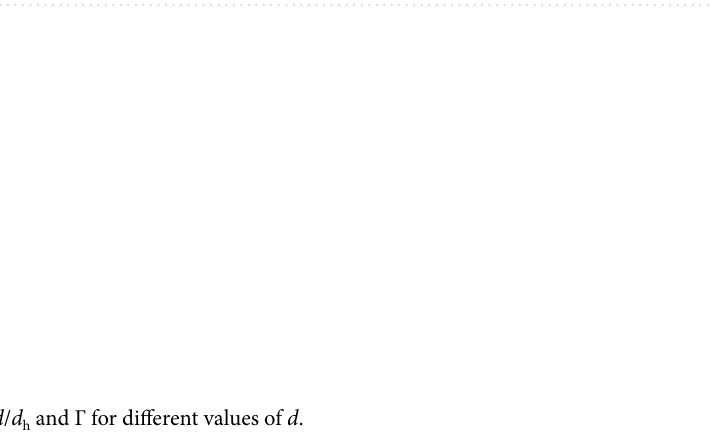
Table 6. Upper limit of simultaneously identified relative activities of gamma sources in distance of 2.0 m from center of gamma finder.